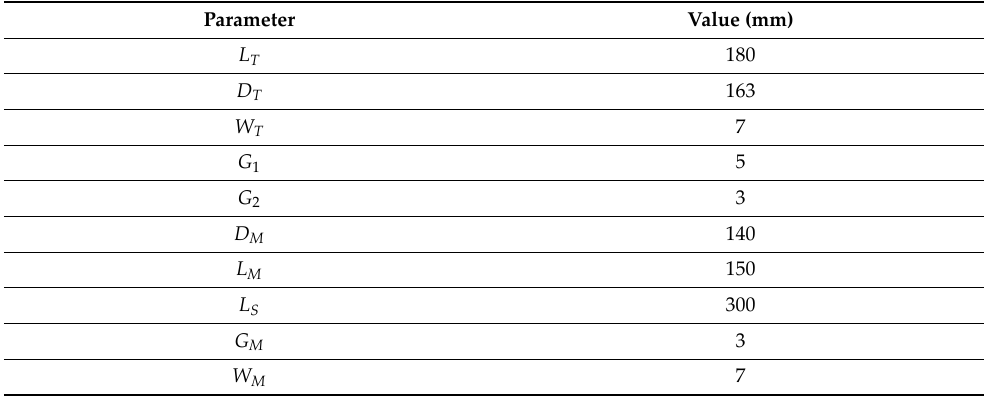
Figure 2. Configuration of: ( a ) Tx/Rx coils, (b) MS unit cell (left) and MS screen consisting of 2 × 2 Figure2. Configurationof: ( a )Tx/Rxcoils, (b) MSunitcell(left)andMSscreenconsistingof2 × 2unit unit cells (right). cells (right). Table 1. Dimensions for Tx, Rx, and MS Unit Cell. Table 1. Dimensions for Tx, Rx, and MS Unit